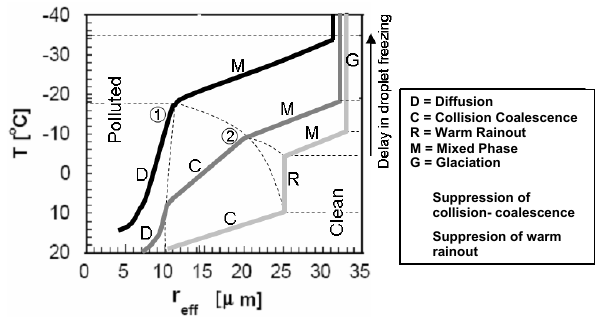
Fig. 1. Conceptual diagram adapted from Rosenfeld and Wood- ley (2003), describing 5 microphysical stages (droplet growth by diffusion, collision-coalescence, warm rainout, ice-water mixed phase, and glaciated phase) common to deep convective clouds and their response to the concentration of pollution aerosols. The bot- tom curve shows the case of a maritime environment with low CCN concentration and the possibility of warm rain processes; the middle curve corresponds to commonly found continental cases, where the larger number of CCN aerosols helps to suppress warm rain process and glaciation starts at slightly lower temperatures; the top curve represents extremely polluted cases where the very large number of CCNs produce smaller and more numerous droplets at cloud base suppressing the beginning of collision-coalescence processes, and postponing the start of droplet freezing to much lower temperatures. Intermediate situations to the above curves are also